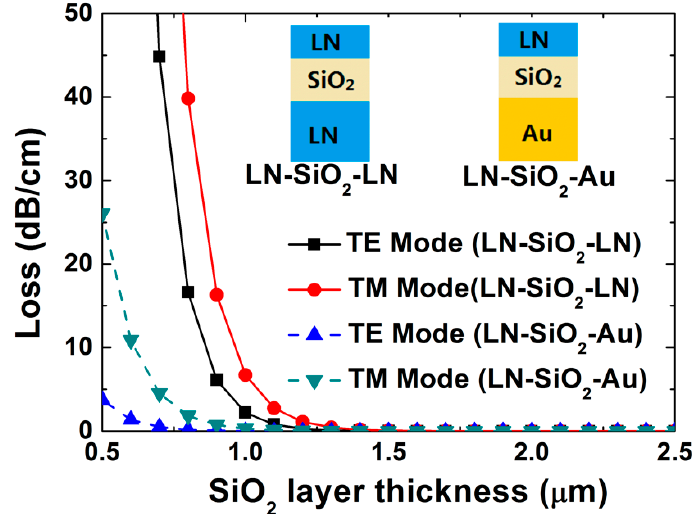
Figure 4. The propagation losses of LN planar waveguide with the different SiO 2 layer thicknesses.